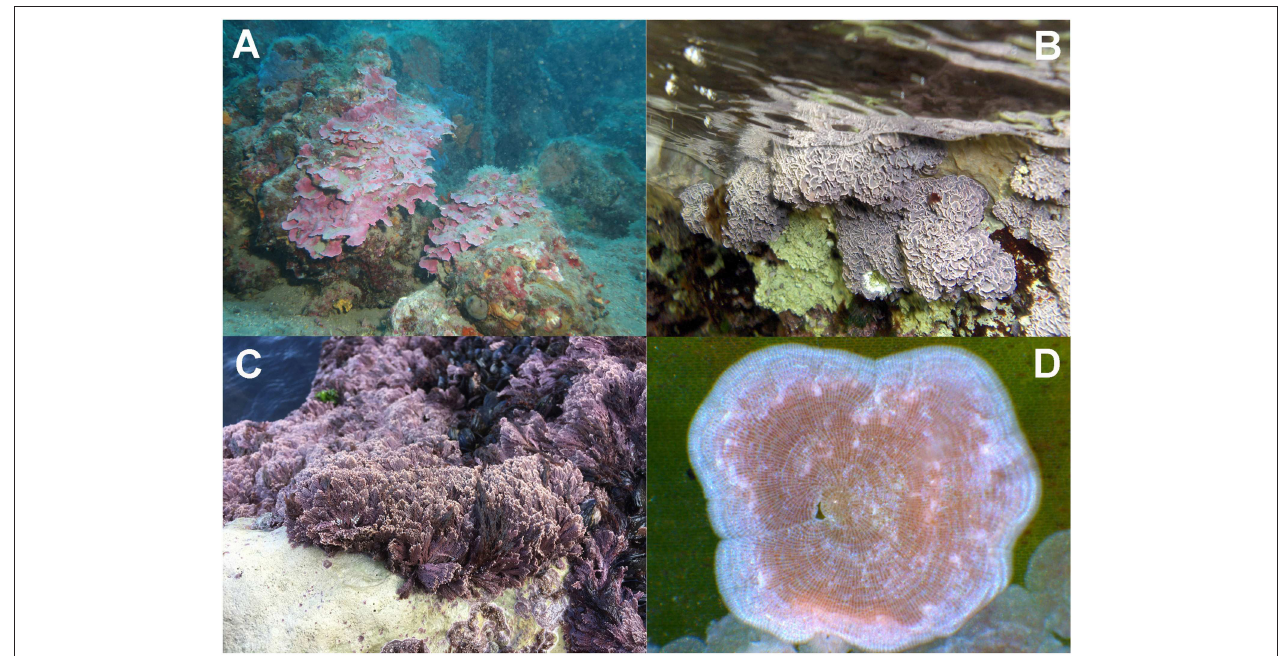
FIGURE 3 | Examples of Mediterranean corallines that have been subject of many studies. (A) Lithophyllum stictiforme , bioconstructor species of coralligenous concretions (reported in many studies as Lithophyllum cabiochae ); copyright: Carlo Cerrano (c.cerrano@univpm.it). (B) Lithophyllum byssoides forms biogenic rims (”trottoirs”) in the intertidal zone; copyright: Sara Kaleb (sara.kaleb@gmail.com). (C) Articulated corallines (usually identified as Ellisolandia elongata ) are common in the Mediterranean low intertidal and shallow subtidal zones. (D) Pneophyllum fragile , a common epiphyte on the leaves of the seagrass Posidonia oceanica ; copyright: Maria Cristina Gambi (gambimc@gmail.com). All pictures were provided by the copyright owners and reproduced with their